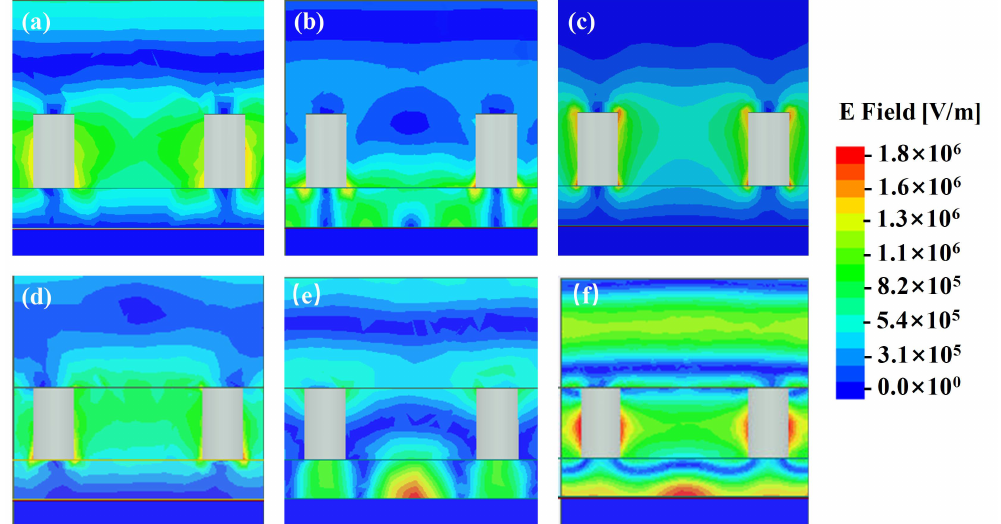
Figure 8. The electromagnetic field profile for the structures, ( a ) without graphene at 3.7 THz, ( b ) without graphene at 6.5 THz, ( c ) without graphene at 7.6 THz, ( d ) with graphene at 3.7 THz, ( e ) with graphene at 6.5 THz, ( f ) with graphene at 7.6 THz.